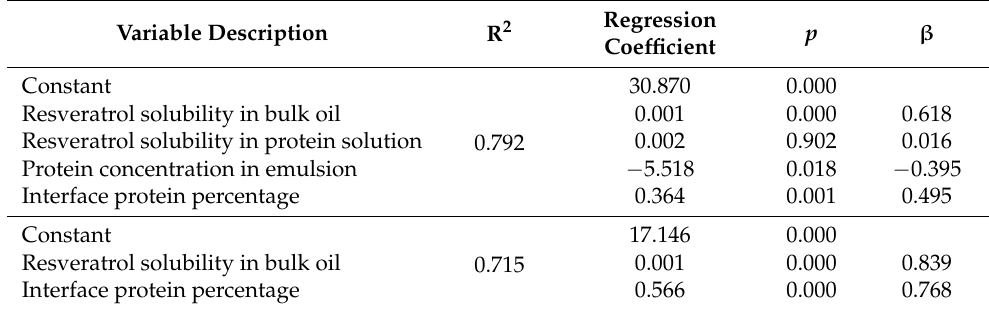
Table 6. Multiple linear regression analysis of the percentages of resveratrol at the oil–water interface of fish oil, MCT and peppermint oil